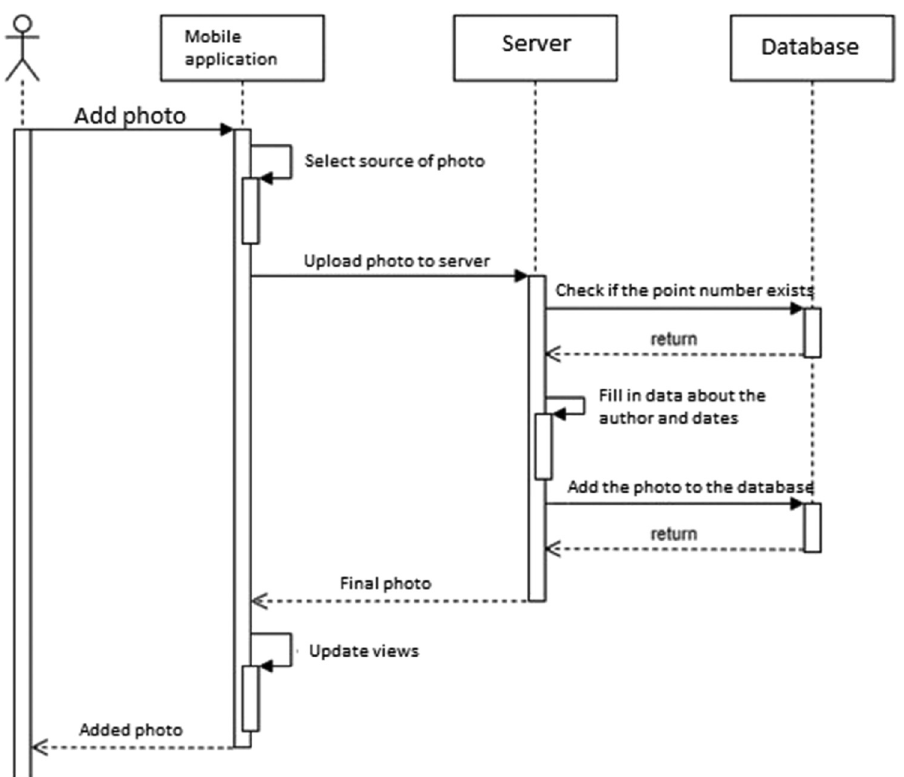
Figure 3: Schema of data fl ow.